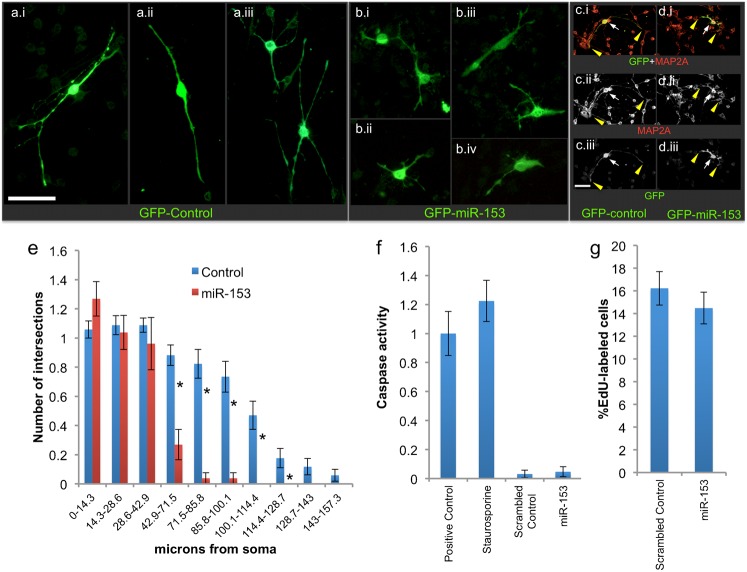
Effects of miR-153 over-expression on differentiation, apoptosis and cell proliferation.(a,b) Photomicrographs depicting GFP immunofluorescent cells cultured under mitogen-withdrawal-induced differentiation conditions on a laminin substrate 48 hours after transfection with GFP control vector (a.i–a.iii) or with GFP-premiR-153 (b.i–b.iv). MiR-153 over-expressing cells exhibited deficient morphological transformation compared to control cells. (c,d) Differentiating control-GFP (c.i–c.iii) and miR-153/GFP (d.i–d.iii) over-expressing cells exhibit co-localized expression of the early neuronal marker Map2a/b (white arrows). Yellow arrowheads show that the GFP label fills the cellular processes and completely overlaps the expression of Map2a/b. Map2a/b immunolabeling also shows deficient morphological transformation following miR-153/GFP over-expression. (e) Bar graph depicts Sholl analysis of neurite length expressed as number of intersections (y-axis) as a function of distance from soma (x-axis) per cell. MiR-153 over-expressing cells have shorter neurites compared to controls. Data based on analysis of 34 control and 26 miR-153-over-expressing cells. Photomicrographs were obtained from all four quadrants of each culture dish, and cells whose processes showed no overlap with those of an adjacent cell were selected for analysis. Asterisks, all p-values <0.02. (f) Pan-caspase activity was measured as an estimate of apoptosis. Caspase activity was high in U937 cells treated with camptothecin (4 µg/ml for four hours, positive control) and staurosporine (2 µM for two hours)-treated neurosphere cultured cells and low in neurosphere cultures transfected with control or pre-miR-153 expressing vectors. There was no statistically significant difference between the latter two conditions (n = 6). (g) EdU incorporation into DNA was used as a marker for cell proliferation. The percentage of labeled cells was not significantly different indicating that cell proliferation was not altered by miR-153 overexposure. Data based on three independent transfection experiments. One photomicrograph was obtained from each quadrant of the culture well (three culture wells per sample) and labeled and total number of cells counted. Scale bars: 100 µm.